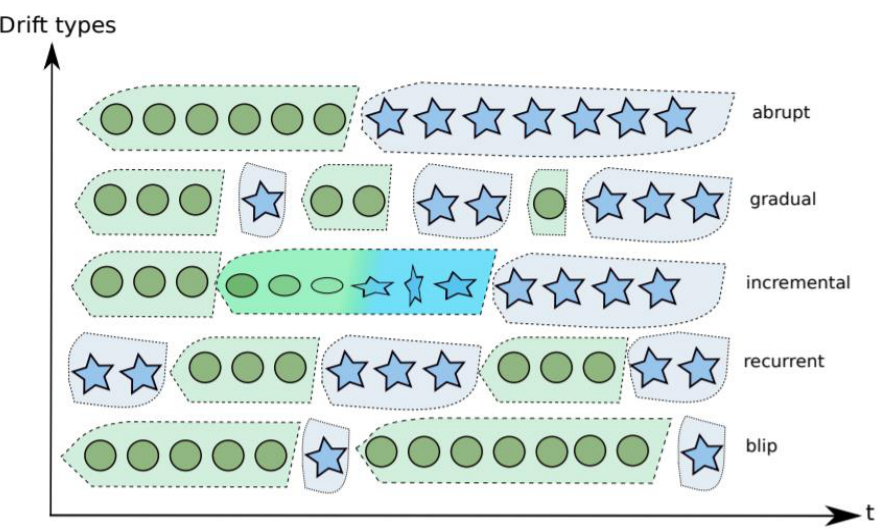
Figure 1. Types of drift according to severity and speed of changes, and noisy blips. Here the stars and circles represent the prevailing concept at every time instant [31].